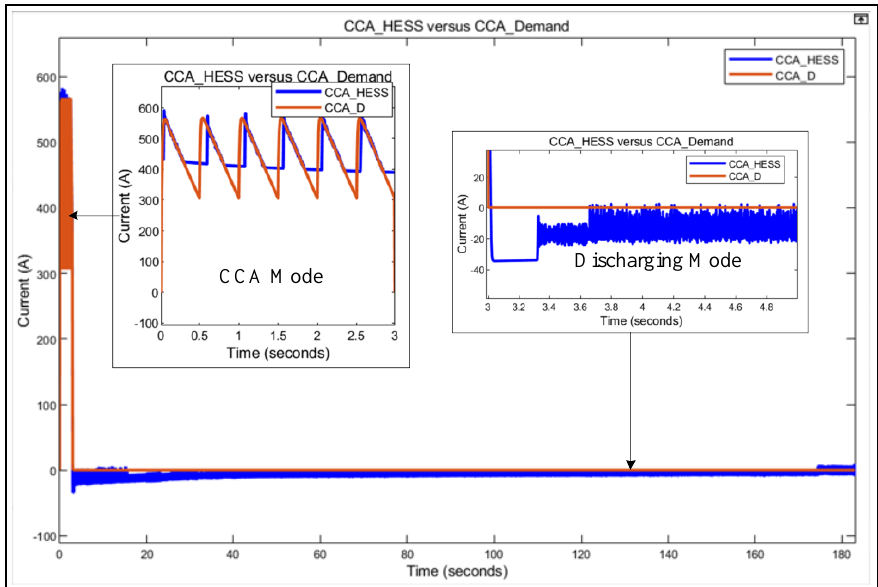
Figure 9. The CCC is supplied by the HESS for case two (b).